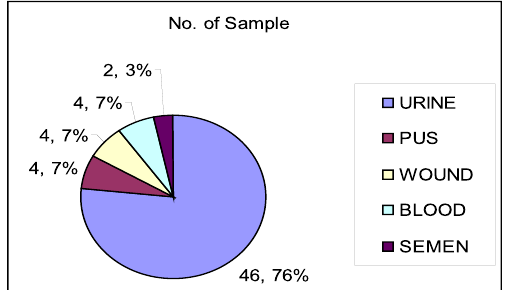
Fig. 1. Distribution of sample collection.